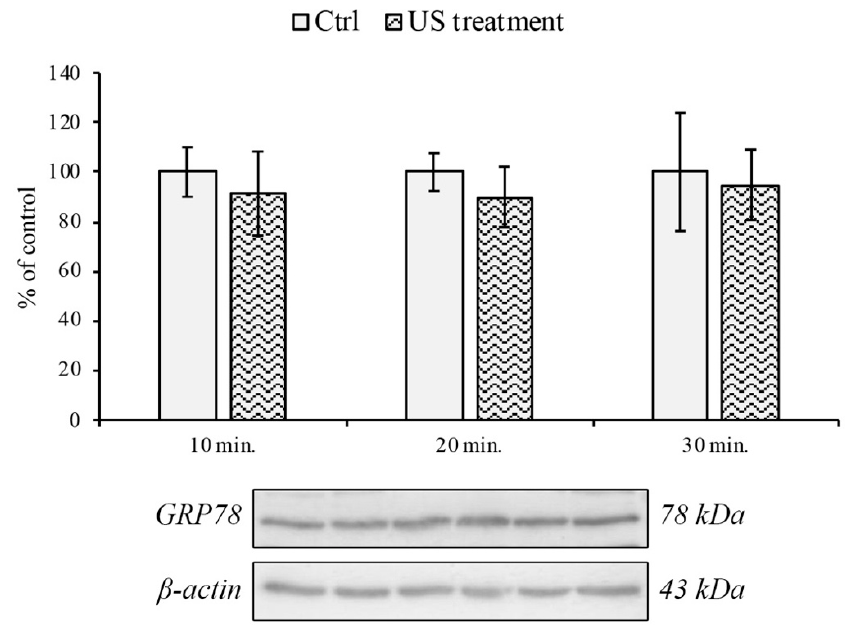
Figure 3. GRP78 protein expression on RBE4 cells during US treatment. Western blotting analysis and quantification of the ER stress marker GRP78 on the RBE4 cell line during US stimulation at 10, 20 and 30 min. time-points. Values are reported as the percentage of the control (untreated cells), arbitrarily taken as 100%. The results are expressed as the mean ± S.E.M. of three independent experiments, performed in triplicate.